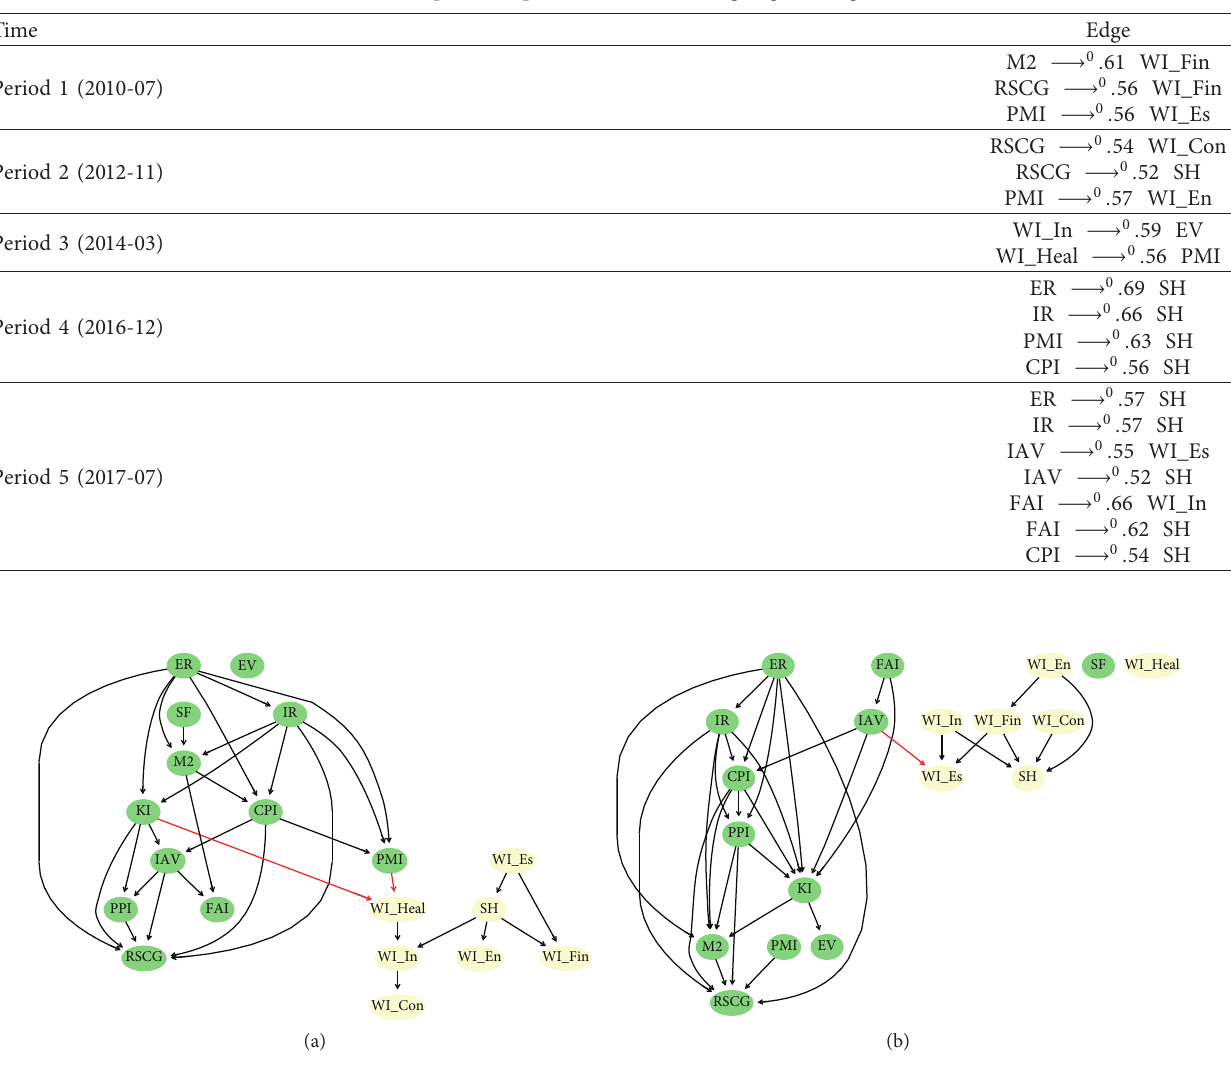
Figure 4: Bayesian network structure constructed from (a) [2014-04, 2015-05]; (b) [2018-01, 2018-12].